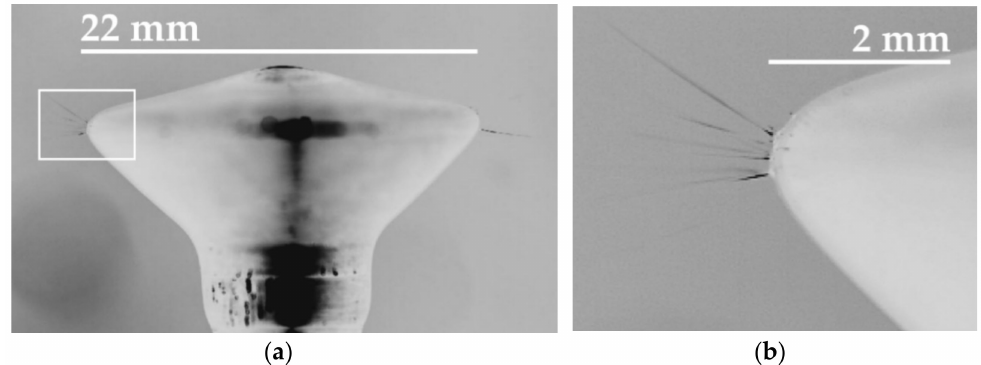
Figure 2. A disc-shaped steel overflow electrode ( a ) was used in the experiments. The white rectangle shows a detail of the edge ( b ) of the electrode on which the high-speed camera focused. The creation and subsequent collapse of the jets was observed and recorded only on the edge of the electrode tip due to the presence of the highest level of electrical